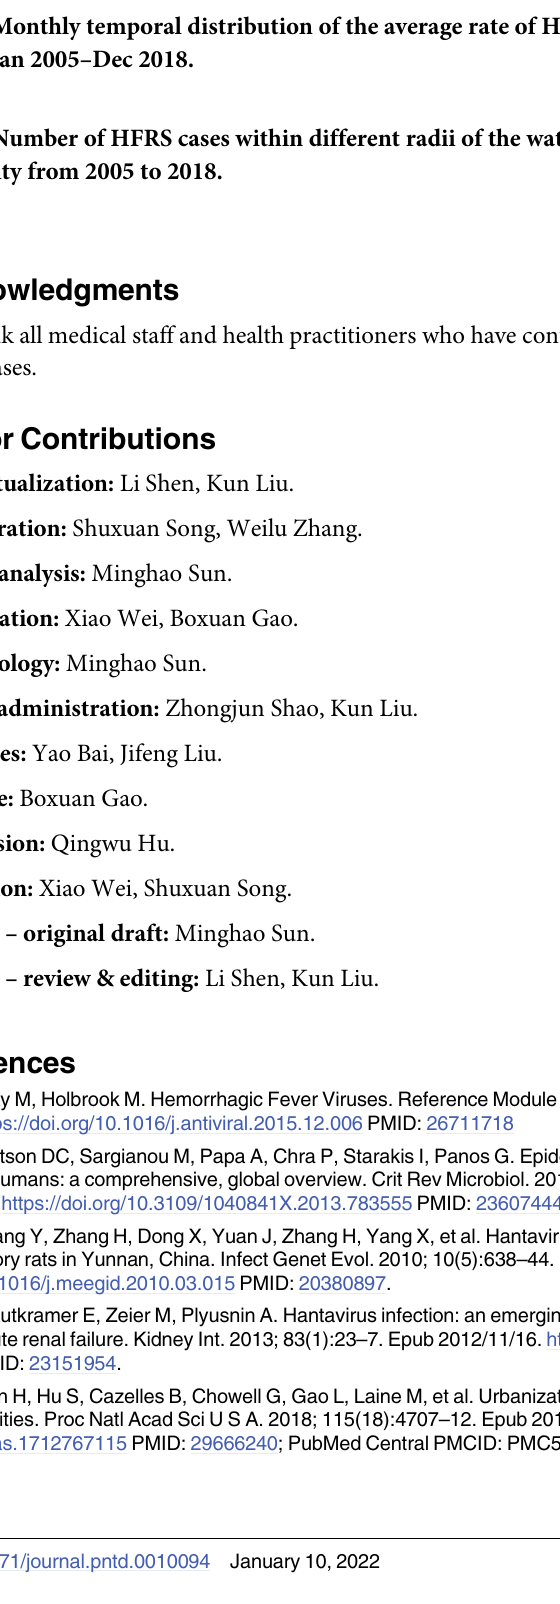
S3 Fig. Monthly temporal distribution of the average rate of HFRS incidence in Xi’an for period Jan 2005–Dec 2018. S4 Fig. Number of HFRS cases within different radii of the water bodies for each year for Xi’an City from 2005 to